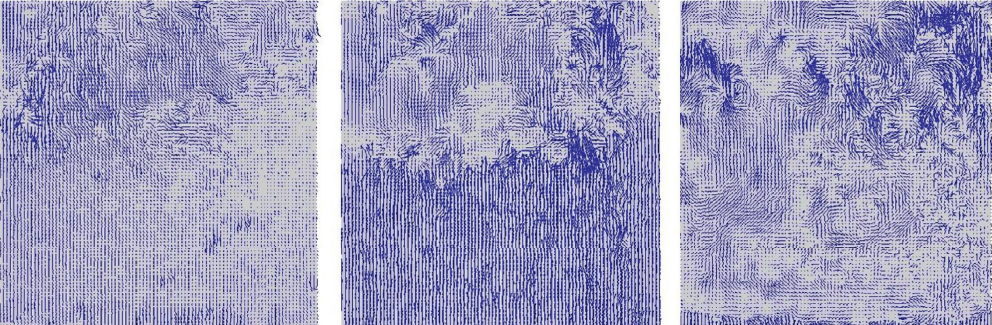
Figure 4: Velocity vector on the axial section of 20g, 30g, and 40 g, respectively.